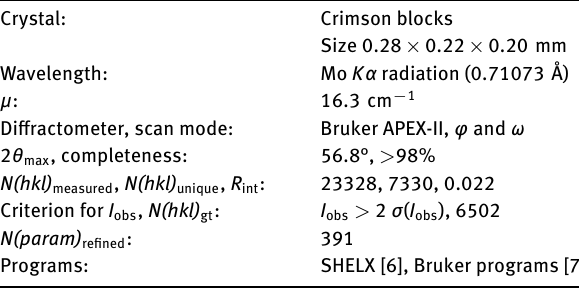
Table 1: Data collection and